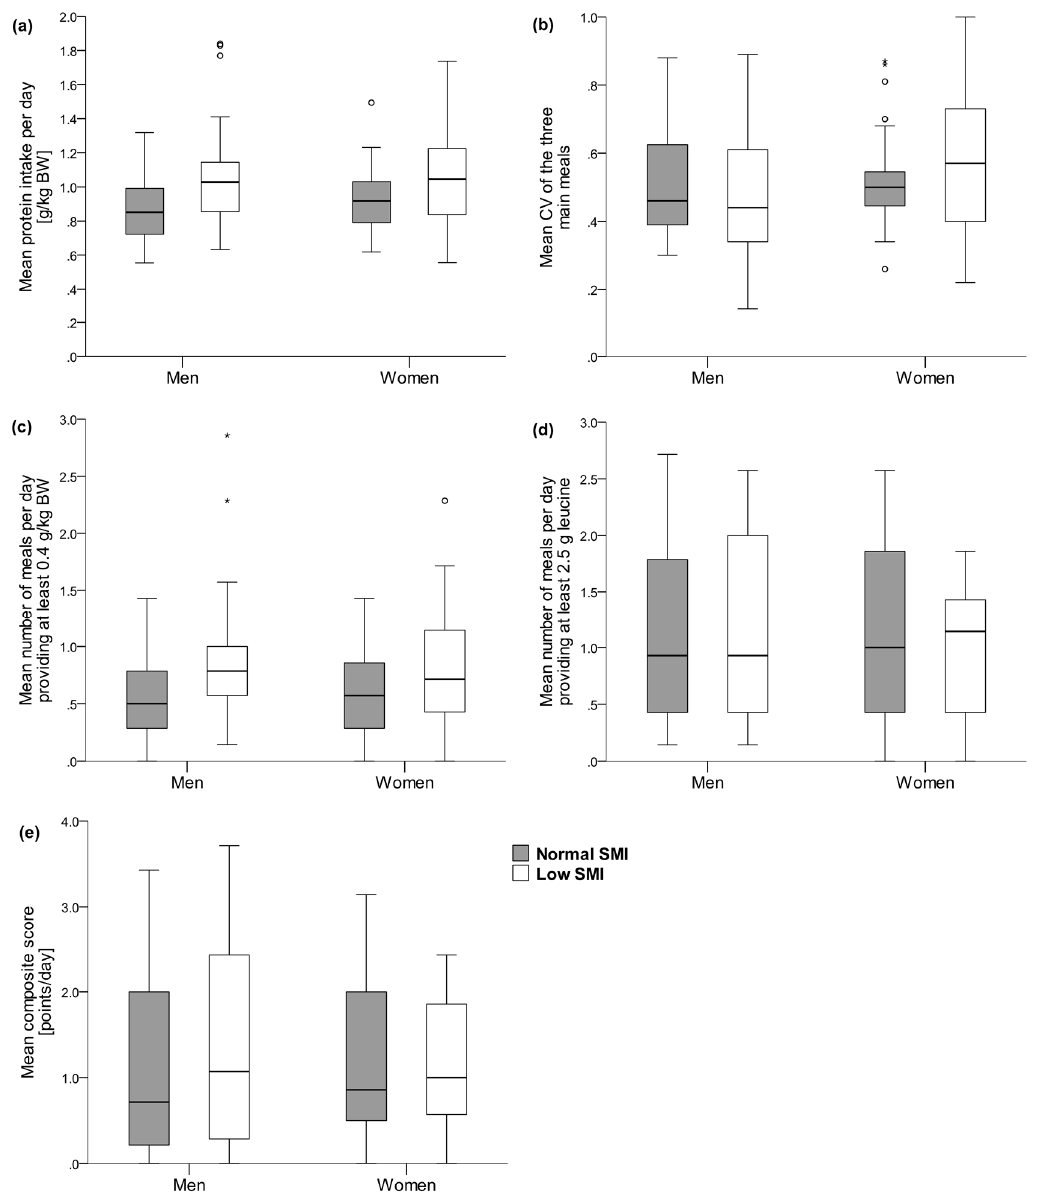
Figure 2. Mean daily intake of protein ( a ), mean coefficient of variance across main meals ( b ), mean number of meals providing at least 0.4 g protein/kg BW per day ( c ), mean number of meals providing at least 2.5 g leucine per day ( d ) and mean composite score representing protein intake pattern ( e ) obtained from 7-day food records in healthy community-dwelling older men with normal ( n = 30) and low ( n = 19) skeletal muscle index (SMI) and in women with normal ( n = 31) and low ( n = 17) SMI. Abbreviation: CV: coefficient of variance of protein intake (g) at breakfast, lunch, and dinner. The composite score combines all four aspects of protein intake: daily amount, number of meals providing ≥ 0.4 g/kg BW protein, number of meals providing ≥ 2.5 g leucine, and evenness of protein distribution across breakfast, lunch, and dinner. Score range: 0–4 points per day, best: 4 points. All p > 0.05, Mann–Whitney U test. The boxes represent interquartile ranges with the bold horizontal lines denoting the median. The whiskers show the highest and lowest values within the 1.5-fold interquartile range. The circles represent outliers and asterisks represent extreme outliers.